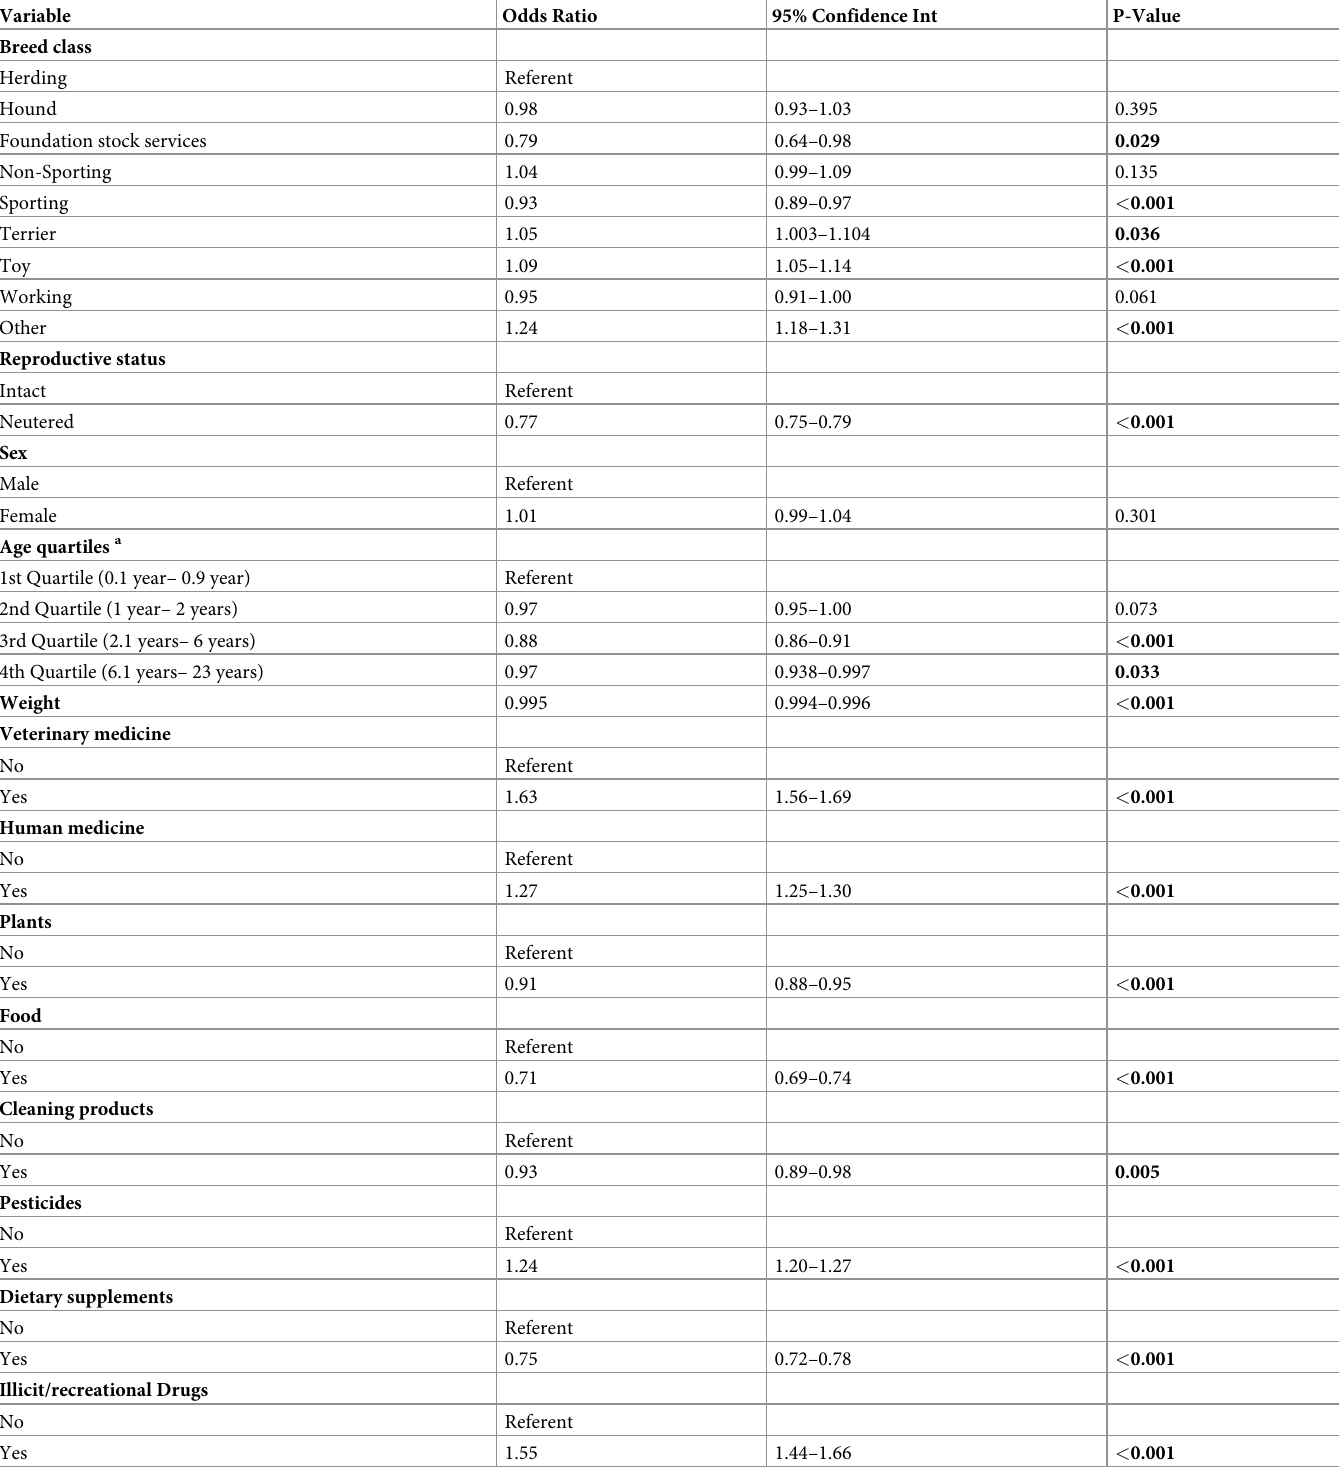
Table 2. Results of � mixed effects univariable logistic regression concerning the association between source of calls (1 = Veterinarian, 0 = Public) to the APCC (2005–2014) and dog demographics, type of toxicant, season, year, and availability of veterinary